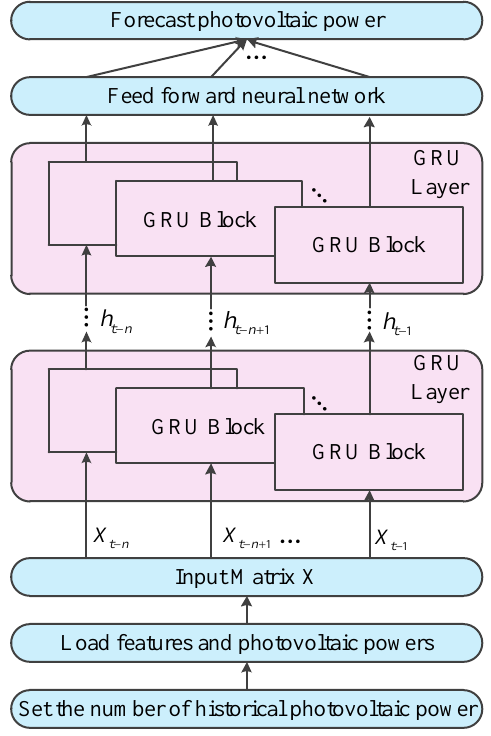
Figure 5. The process forecasting photovoltaic power based on GRU network.